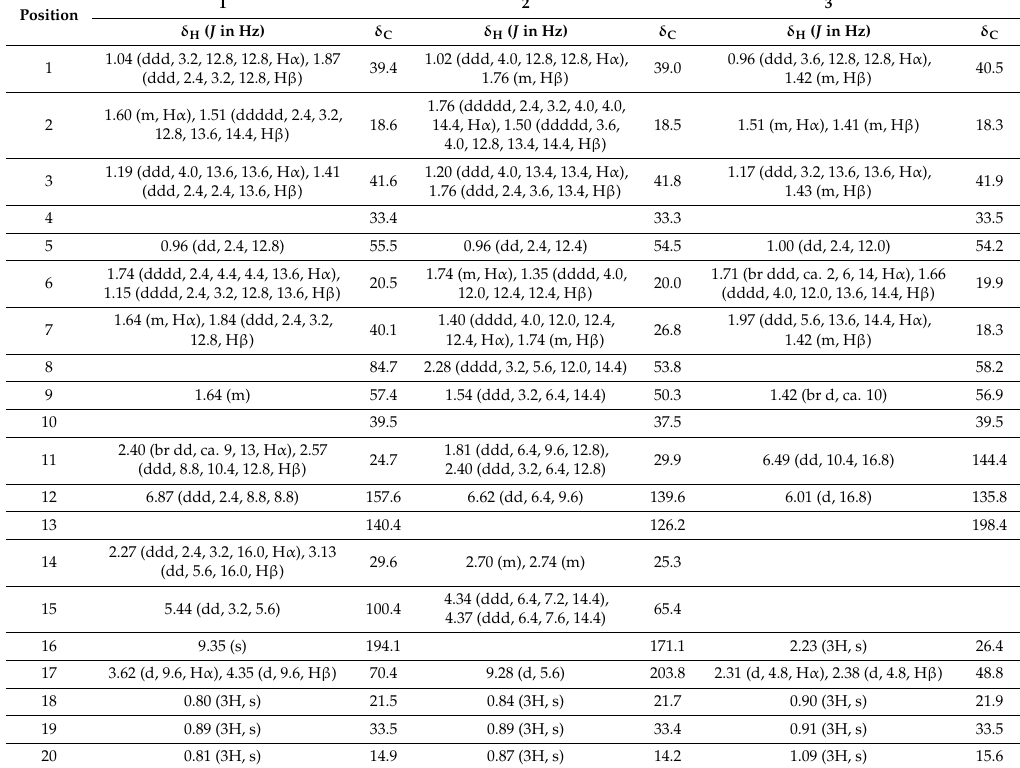
Table 1. NMR data (800 MHz, CDCl 3 ) for galangalditerpenes A–C ( 1 – 3